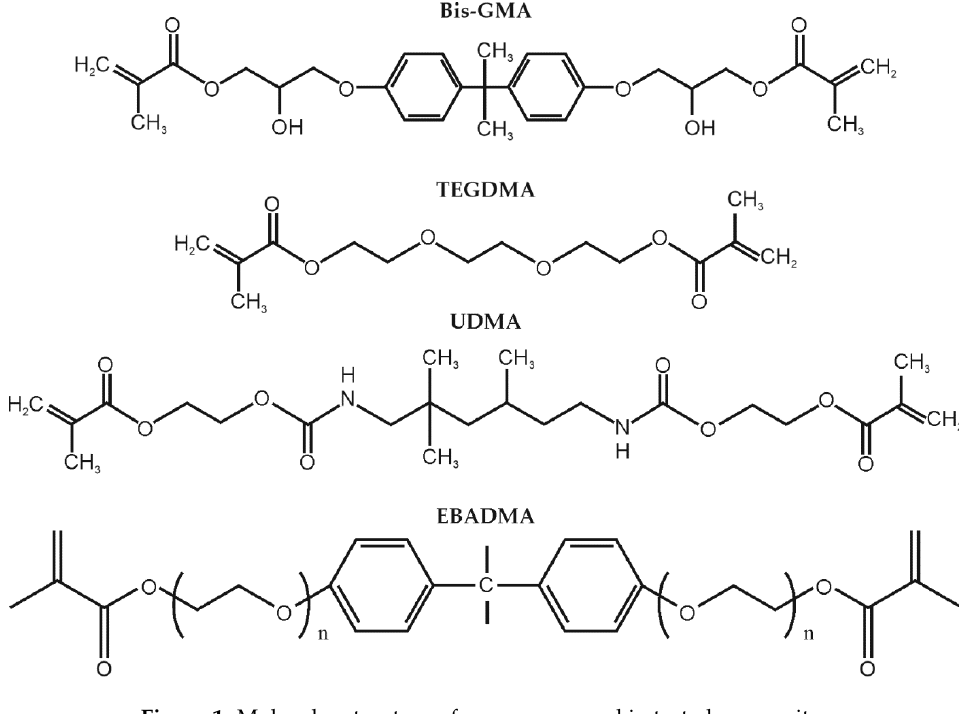
Figure 1. Molecular structure of monomers used in tested composites.